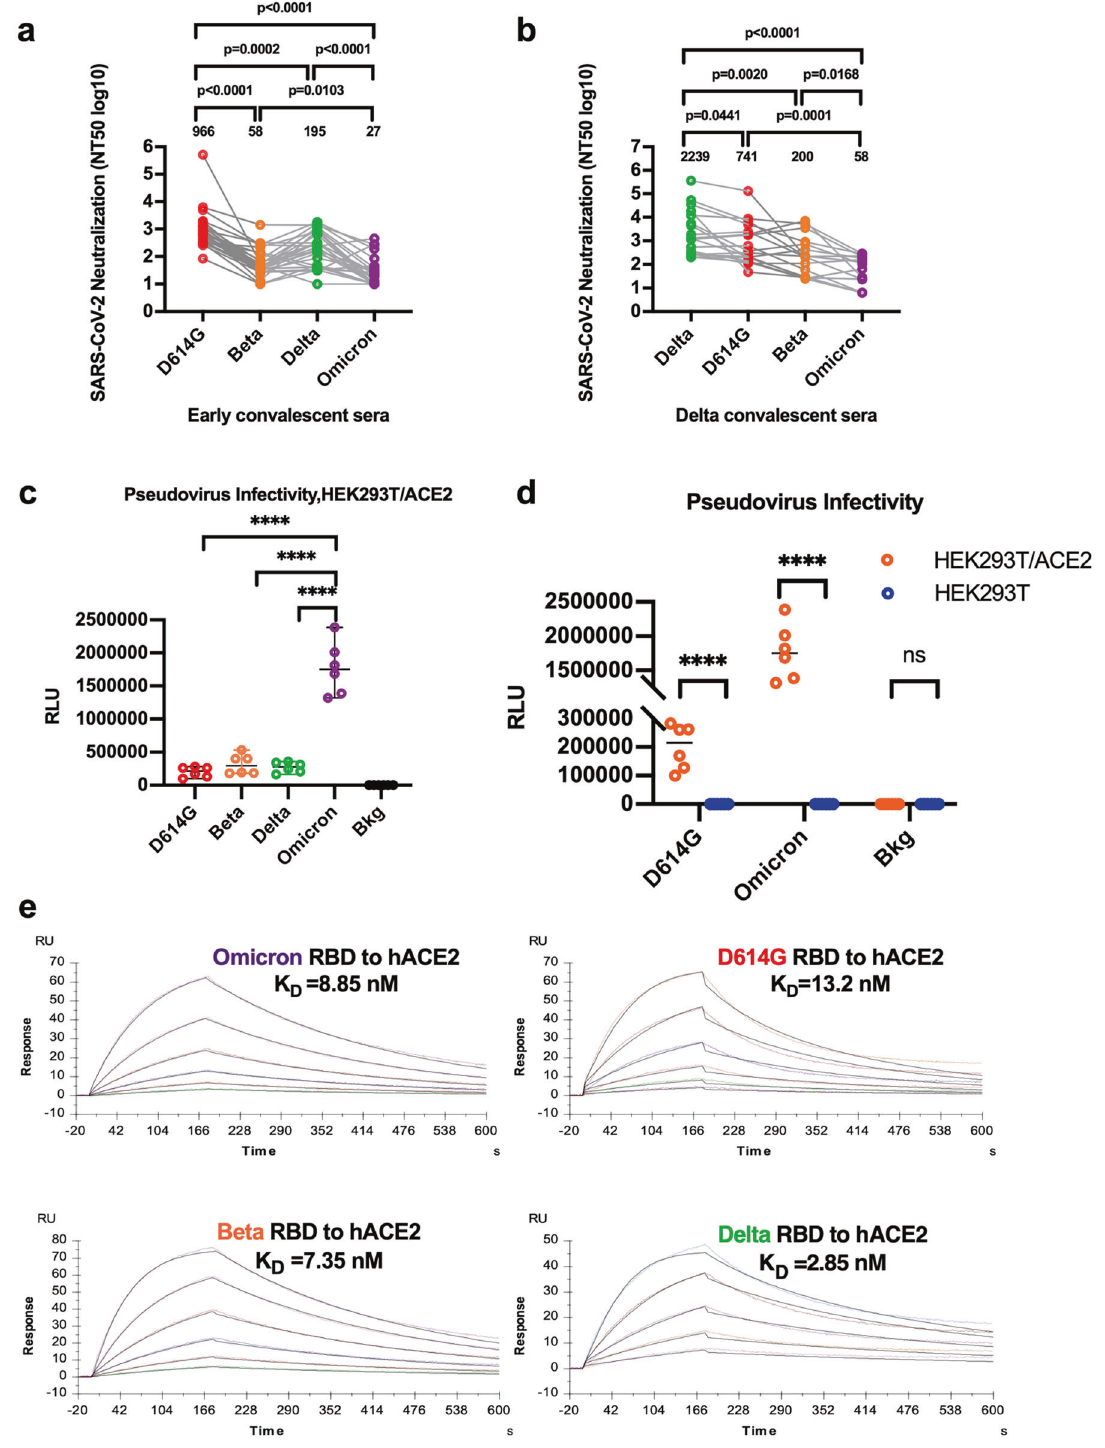
Fig. 1 Omicron variant exhibits potent capabilities for immune evasion and viral entrance. a The neutralizing antibodies (nAbs) titers of early convalescent sera against SARS-CoV-2 pseudoviruses (D614G/Beta/Delta/Omicron) were determined and represented as half-maximal inhibitory concentrations (NT50). ( n = 27, Adjusted p values were calculated by one-way ANOVA with Tukey ’ s multiple comparisons test * p < 0.05, *** p < 0.001). b NT50 of each Delta convalescent sera against each pseudotyped virus ( n = 18 Adjusted p values were calculated by one- way ANOVA with Tukey ’ s multiple comparisons test * p < 0.05, *** p < 0.001). c , d The Omicron pseudoviruses were more infectious than other pseudotyped viruses in HEK293T/ACE2 cells. The relative luminescence unit (RLU) of Luc reporter gene expression was standardized as the p24 content of the pseudoviruses (the p24 content of the pseudovirus in the supernatants: D614G = 287 ng/mL, Beta = 306 ng/mL, Delta = 282 ng/ml, Omicron = 289 ng/ml). The background (Bkg) RLU was measured in the wells that received the cells but not the pseudoviruses. e Surface plasmon resonance (SPR) was used to analyze the af fi nity of Omicron_RBD, D614G_RBD, Beta_RBD, and Delta_RBD bound to ACE2. The K D values were calculated by the software BIAevaluation and shown was a mean of three independent experiments